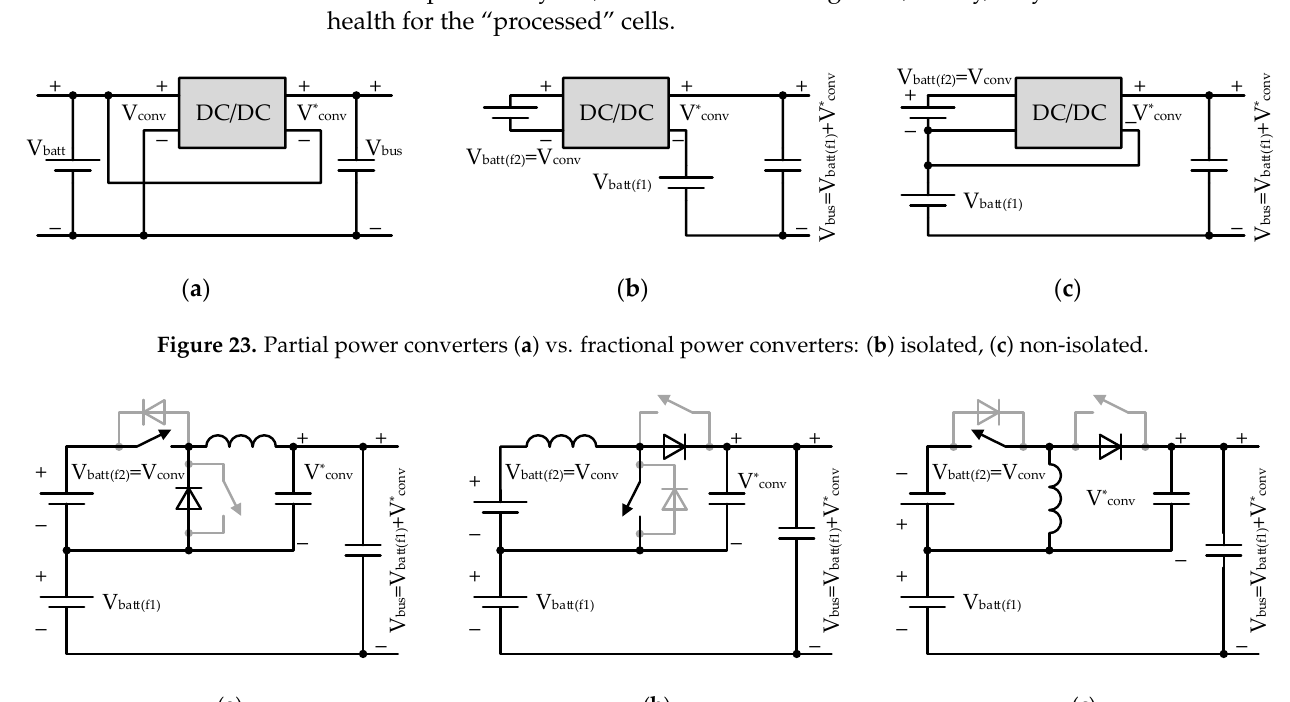
Figure 24. Examples of non-isolated fractional power converters (in discharge mode): ( a ) buck, ( b ) boost, ( c ) buck-boost.